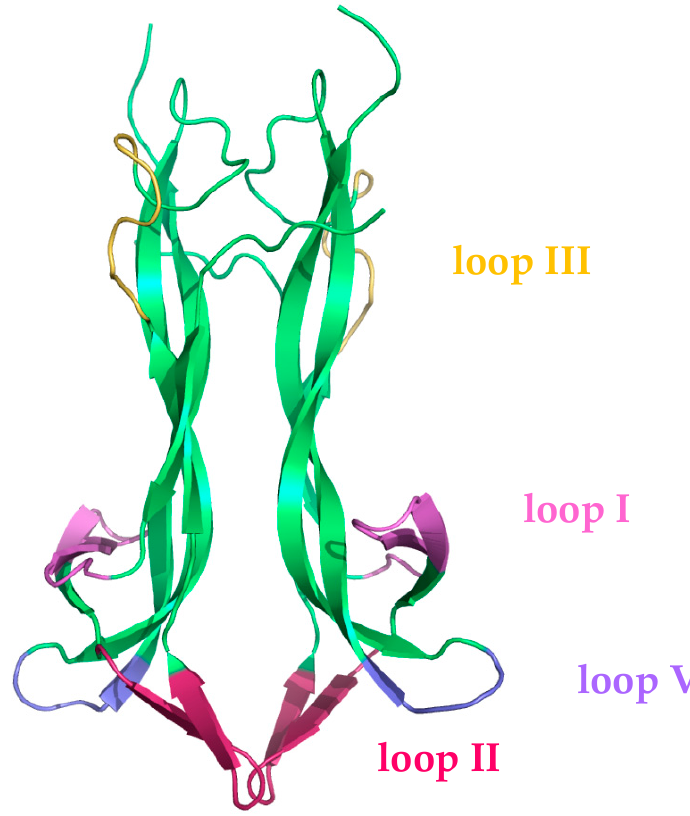
Figure 1. Cartoon representation of hNGF, whose loops are highlighted (i.e., loop I in magenta, loop II in pink, loop III in yellow, and loop V in violet).